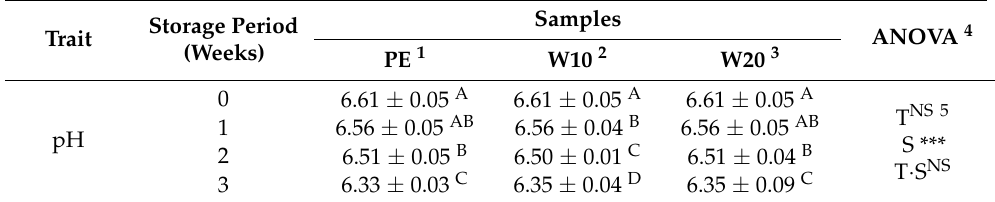
Table 1. pH values of sausages stored in the PE and biodegradable containers manufactured with walnut shell